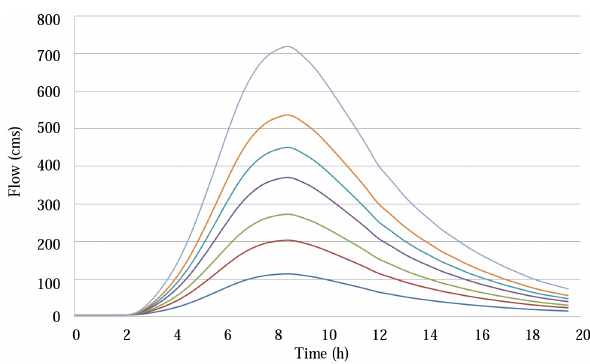
Figure 3. Flood hydrograph in Akcay Creek for 2, 5, 10, 25, 50, 100 and 500-year return